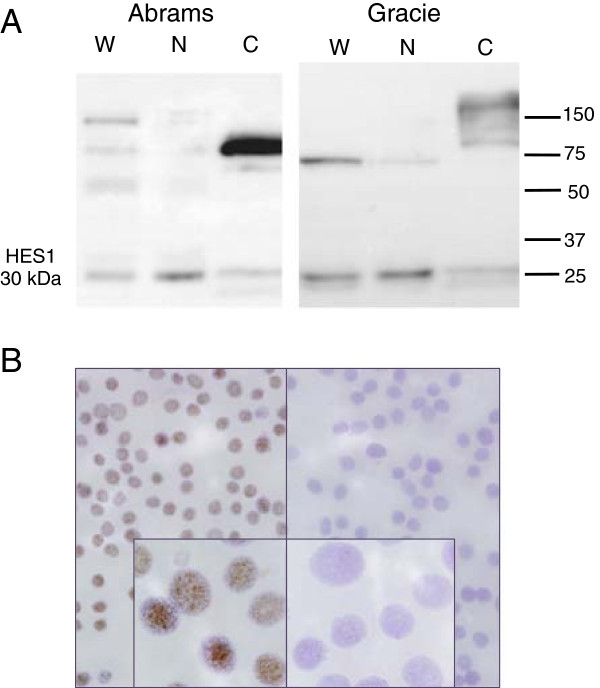
Western blot and immunocytochemistry (ICC) results assessing HES1 expression in canine osteosarcoma cells. (A) Western blot analysis of whole cell (W), nuclear (N) and cytoplasmic (C) fractions of canine osteosarcoma Abrams and Gracie cell lines. A 30 kDa band (HES1) is present in whole cell and enriched in extracted nuclear lysates. Larger non-specific bands are enriched in the cytoplasmic fractions. Equal amounts of total protein were loaded in each lane. (B) ICC shows nuclear staining for HES1 in canine OSA cells (Gracie). Panel on the right is the secondary-only negative control. Photomicrographs were taken at 20× and 100× (oil, inset) magnification; haemotoxylin counterstain.